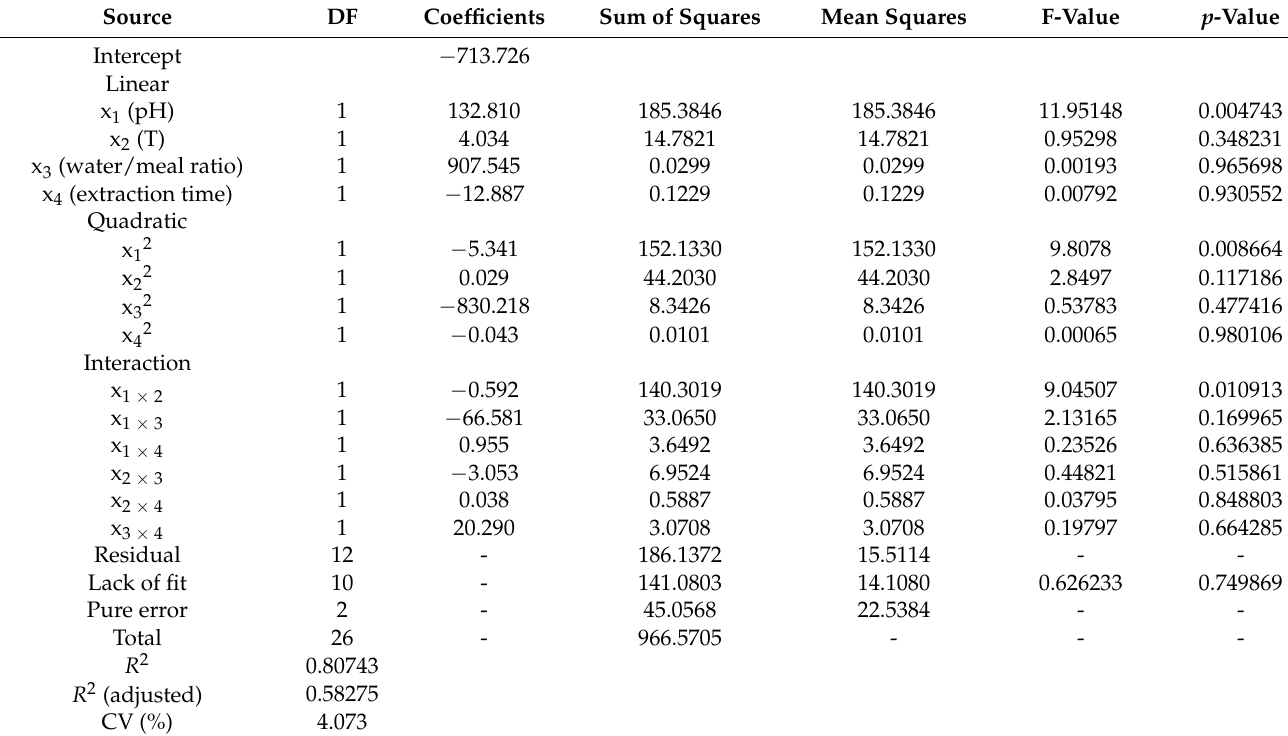
Table 3. ANOVA and regression coefficients of the second-order polynomial model for the response variable (protein purity). Source DF Coefficients Sum of Squares Mean Squares F-Value p -Value − 713.726